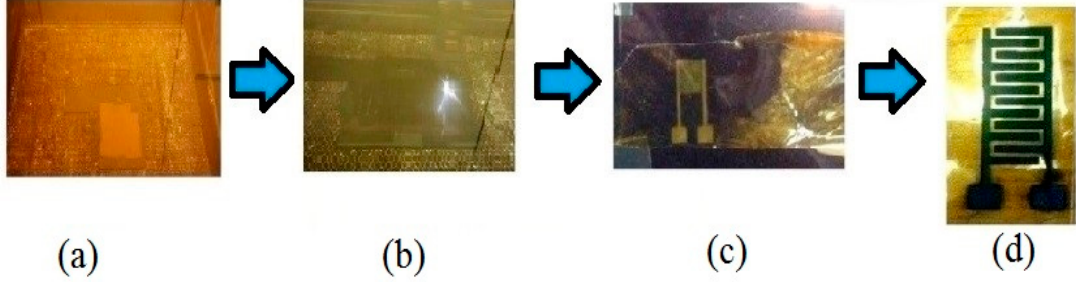
Figure 11. Fabrication of the graphene-PI based sensor. ( a ) The PI film was attached to the glass substrate, ( b ) laser writing on the polymer film to develop the electrodes, ( c ) the laser-induced graphene was transferred to Kapton tapes, ( d ) the final sensor patch after the fabrication process. Reproduced from Nag, A., Mukhopadhyay, S.C. and Kosel, J., 2017. Sensing system for salinity testing